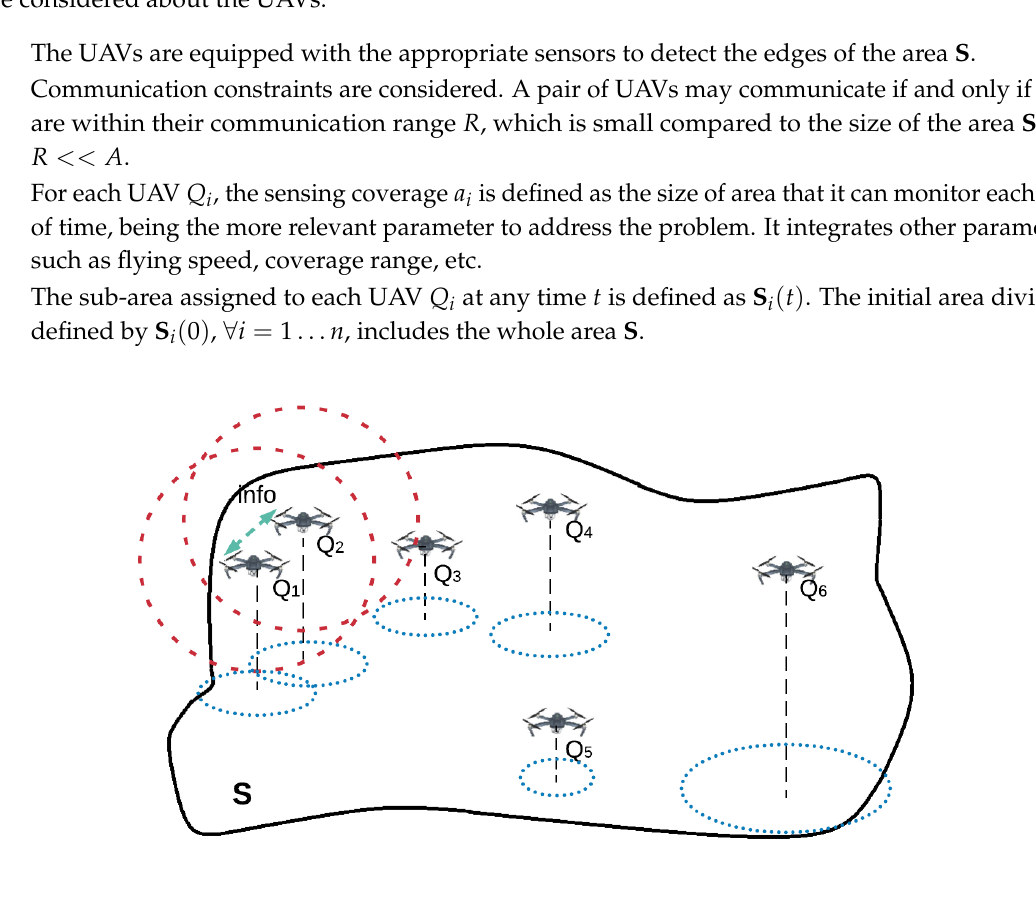
Figure 1. A team of 6 UAVs in charge of monitoring a given area in a cooperative